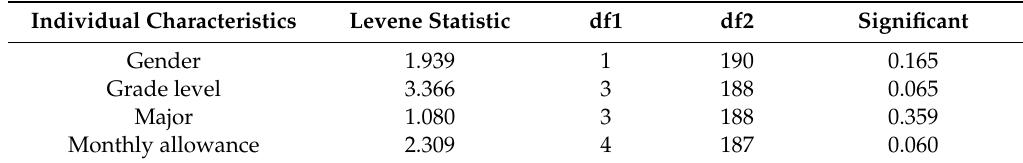
Table 7. Tests of homogeneity of